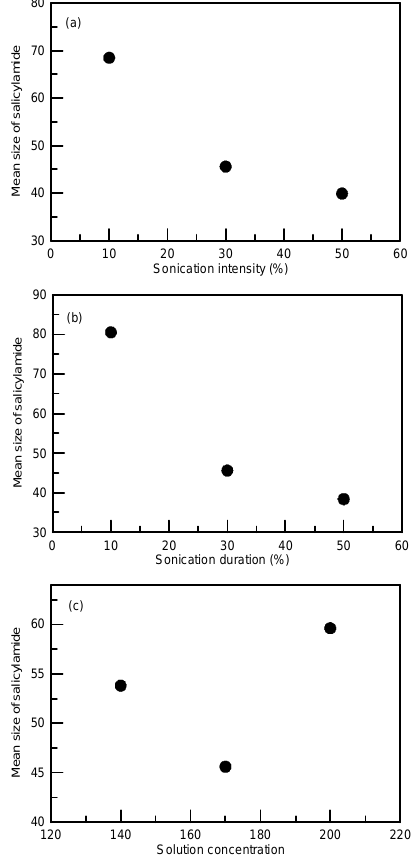
Figure 3. Illustration of the effect of the following operating parameters on the mean size